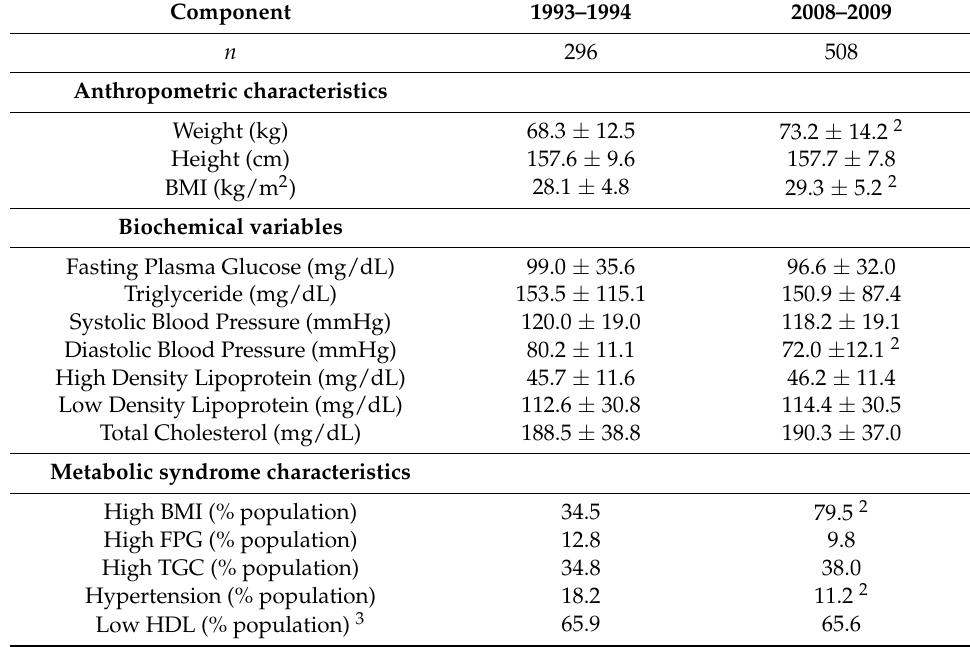
Table 4. Anthropometric and metabolic characteristics of subjects from El Salvador from 1993–1994 and 2008–2009 1